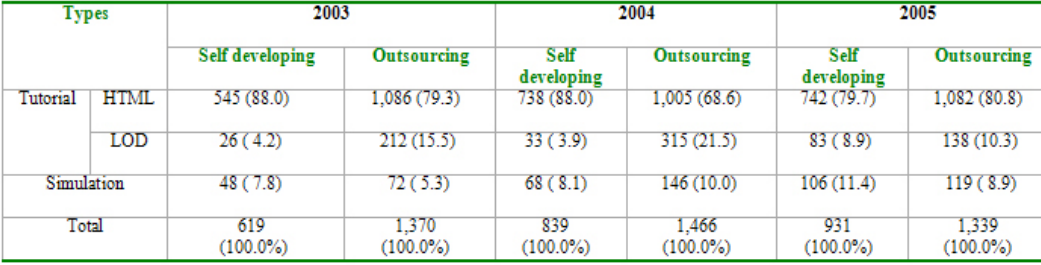
Table 2. e-Learning Program Proportion by Types from 2003 to